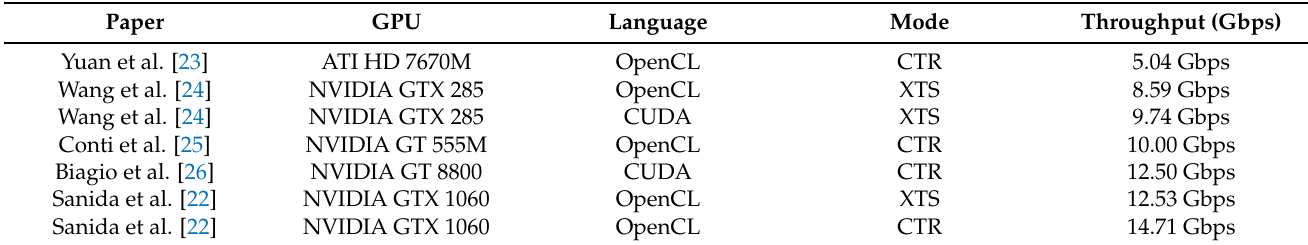
Table 3. AES (Advanced Encryption Standard) fast implementation study results comparison.